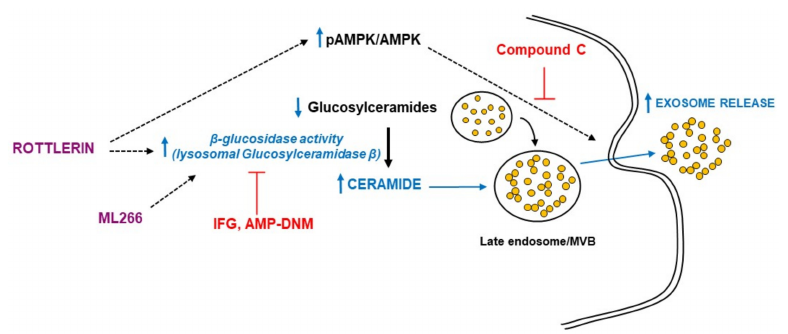
Figure 7. Summary of the rottlerin effects in vitro model of intracellular lipid accumulation. Rottlerin stimulated exosome/microvesicle release via activation of β -glucosidase that degraded glucosylce- ramide, increasing ceramide levels, which facilitated the export of lipids out of the cell and thus ameliorated the endo/lysosomal lipid accumulation in a model of intracellular lipid trafficking impair- ment in glioma cells. AMPK (AMP-activated protein kinase) activation mediated the effects of rottlerin. ML266 is a chemical chaperone that stabilizes β -glucosidase and facilitates its translocation to lysosomes. Compound C is a selective and ATP-competitive AMPK inhibitor. IFG (isofagomine D-tartrate) and AMP-DNM (AMP-deoxynojirimycin) inhibit the β -glucosidase. MVB, multivesicular